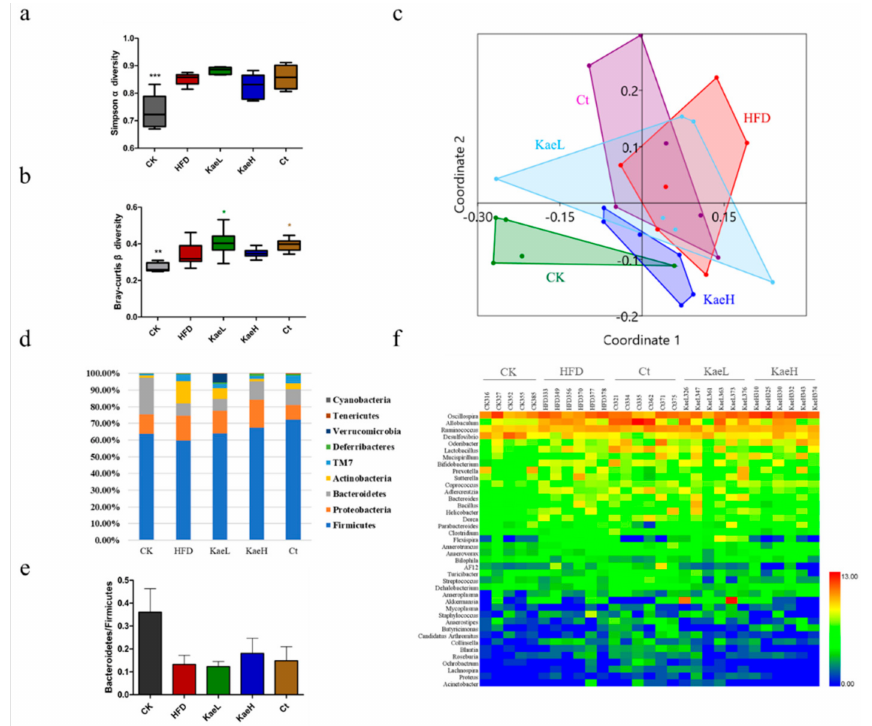
Figure 4. Effect of C. tinctoria and kaempferol on gut microbe. ( a ) Simpson α diversity index among groups. ( b ) Bray-Curtis β diversity index among groups. ( c ) The NMDS graph shows the two- dimensional plane distribution of each group of animals (that is, the degree of difference between groups characterized by β diversity). ( d ) Microbial community analysis at the phylum level in mice. ( e ) The alteration in the Bacteroidetes to Firmicutes ratio in mice. ( f ) Heat map analysis of microbial community at the genus level in mice. CK: control group, HFD: high-fat diet group, Ct: HFD+water extract of C. tinctoria group, KaeL: HFD+kaempferol low group, KaeH: HFD+kaempferol high group. Value = mean ± SD (n = 8). * p < 0.05 vs. HFD, ** p < 0.01 vs. HFD, *** p < 0.001 vs. HFD, **** p < 0.0001 vs. HFD.